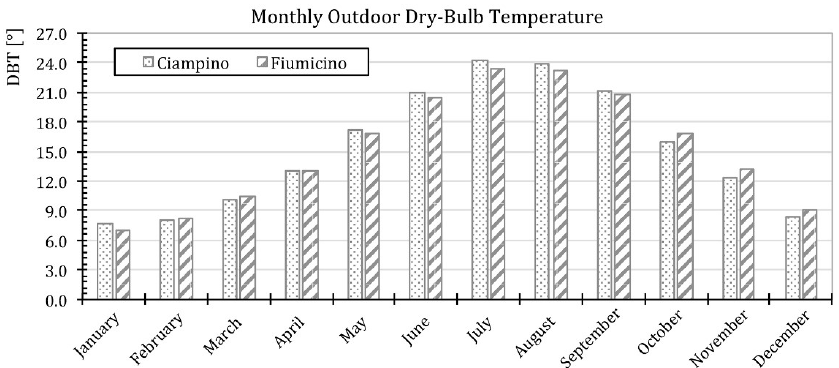
Figure 4. Monthly dry-bulb temperature (TBA (°C)). Data were sourced from climate files provided by the EnergyPlus database for Rome, and correspond to the airports of Fiumicino and Ciampino. This analysis shows that data relative to Fiumicino and Ciampino are consistent, with slight differences due to their different geographical positions and the different orography of the surrounding land.